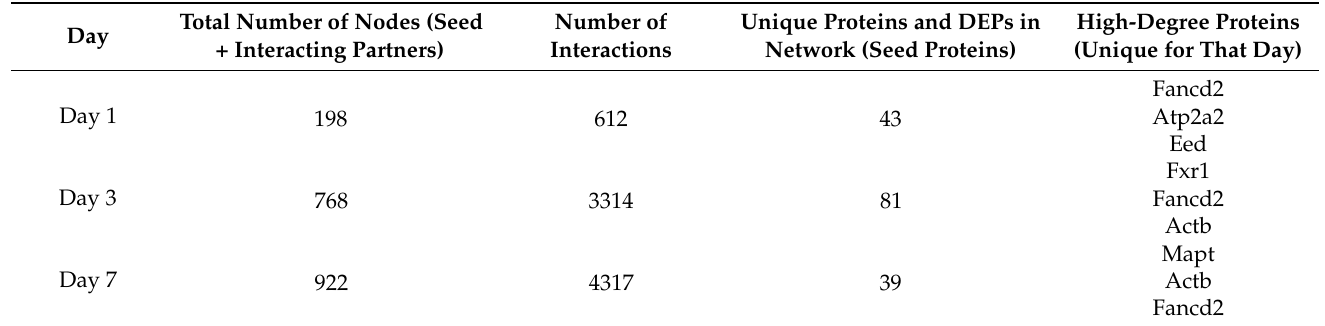
Figure 6. Protein–protein interaction (PPI) networks of unique proteins and DEPs identified in the cross-comparison analysis. A cross-comparative analysis was done at each time point (1, 3 or 7 days after PCAL) to identify unique proteins and DEPs ( p < 0.05). ( A ) Venn diagram of unique proteins and DEPs identified in the DMB vs. vehicle comparison; ( B ) PPI network of unique proteins and DEPs on day 1 post-PCAL; ( C ) PPI network of unique proteins and DEPs on day 3 post-PCAL; ( D ) PPI network of unique proteins and DEPs on day 7 post-PCAL. * Protein unique to the DMB group for that day. # Protein unique to the vehicle group for that day. Table 3. Protein–protein interaction network parameters.